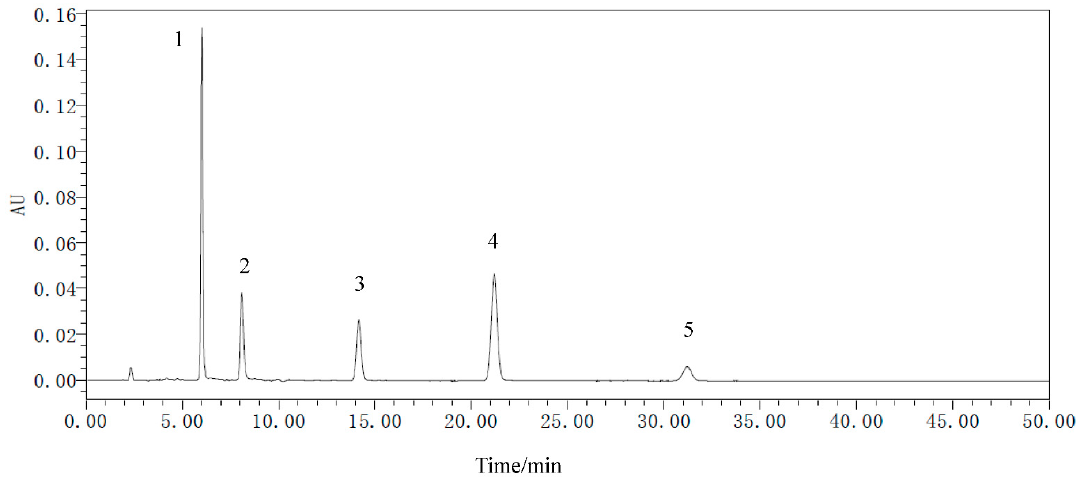
Figure 6. The HPLC of metabolite standards of R. palmatum . 1 is aloe-emodin, 2 is rhein, 3 is emodin, 4 is chrysophanol, 5 is physcion. Table 3. Metabolite content of R. palmatum in different production areas.